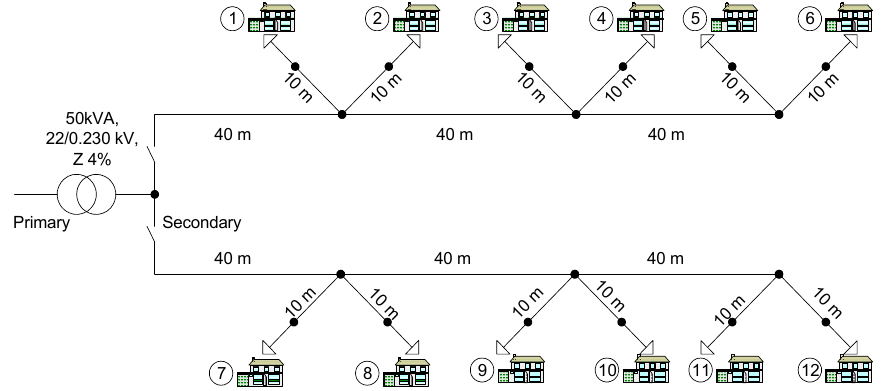
Figure 2. A studied urban village network topology.